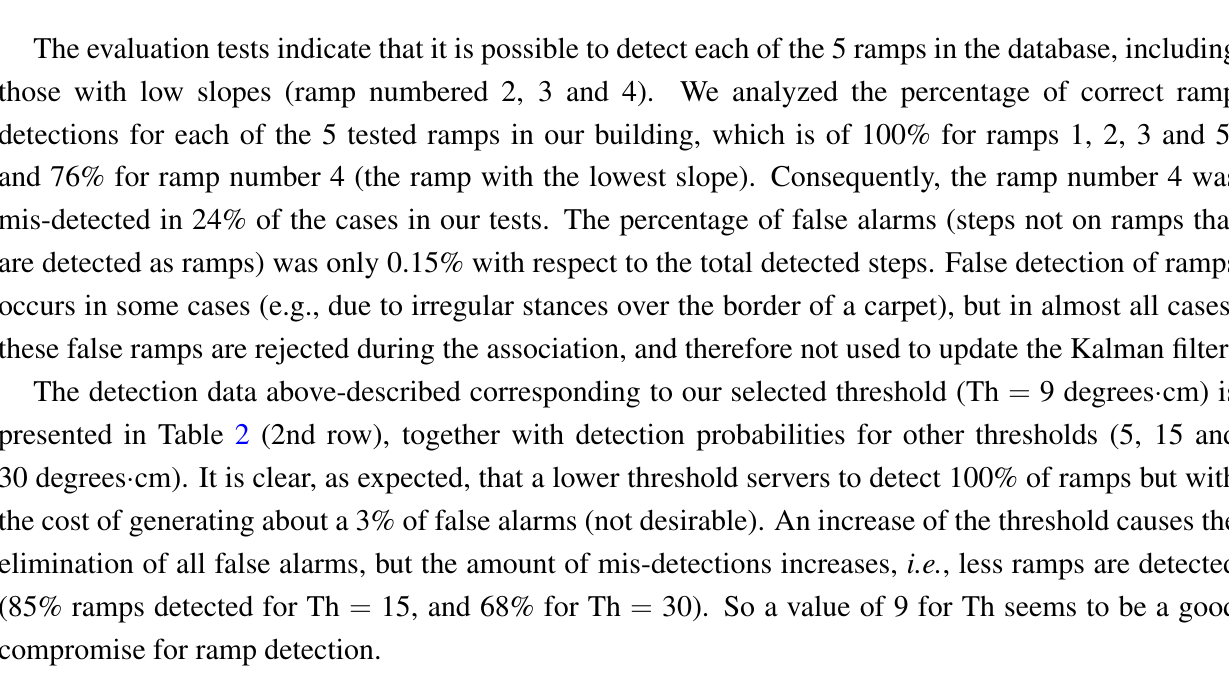
Table 2. Analysis of probabilities for correct ramp detection, mis-detection and false alarm, as a function of the threshold (Th) used to detect a